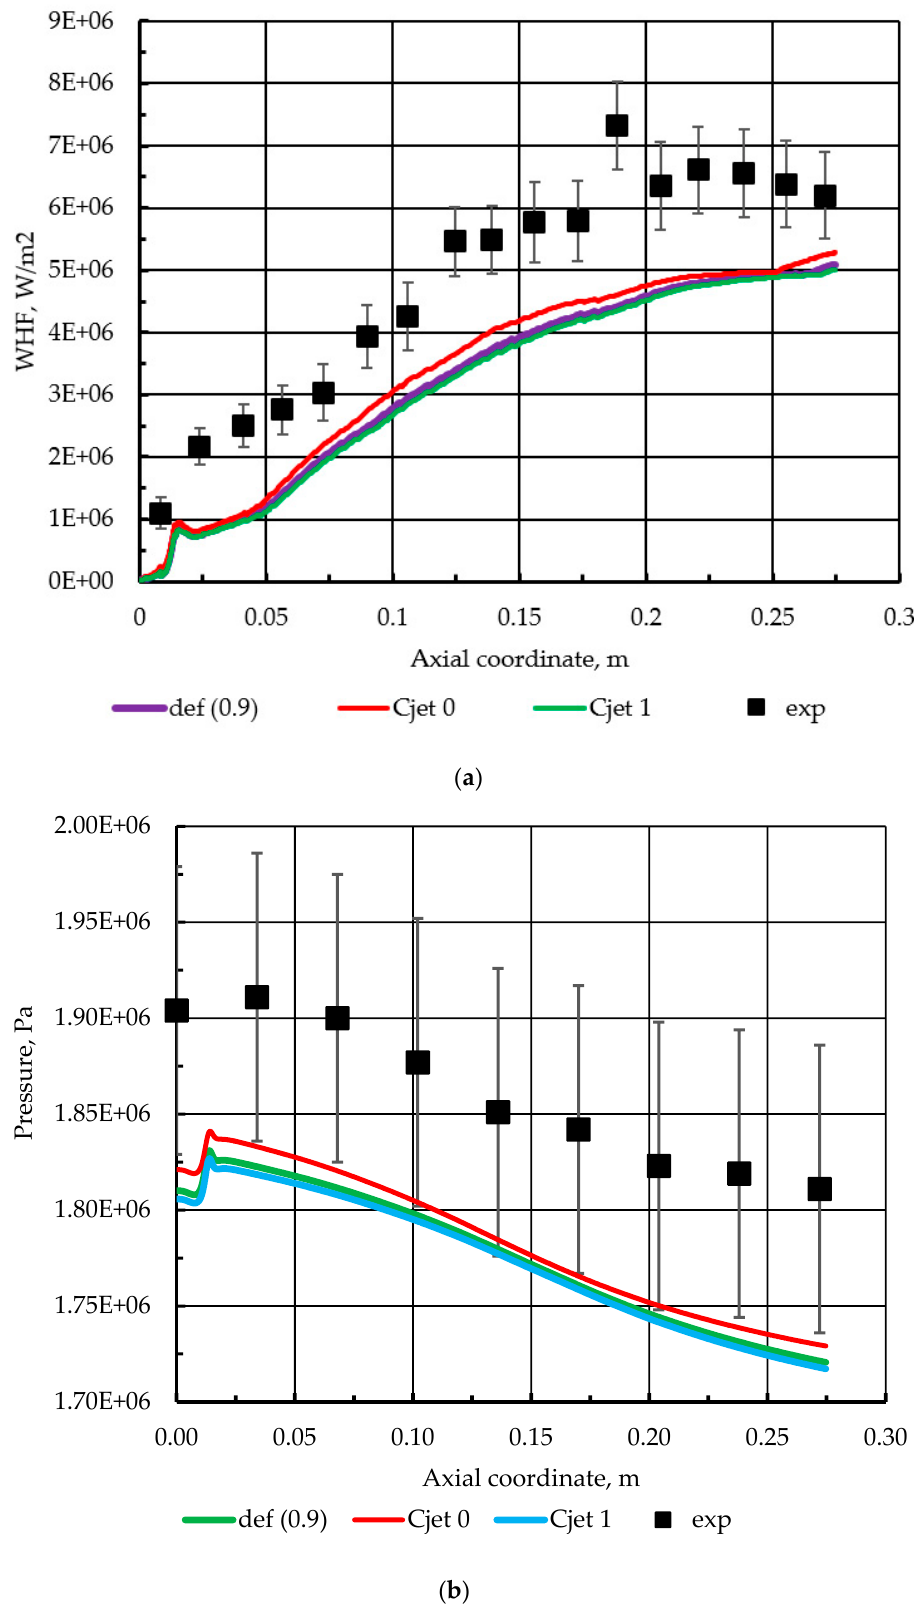
Figure 5. ( a ) Effect of Cjet parameter on wall heat flux; ( b ) Effect of Cjet parameter on pressure